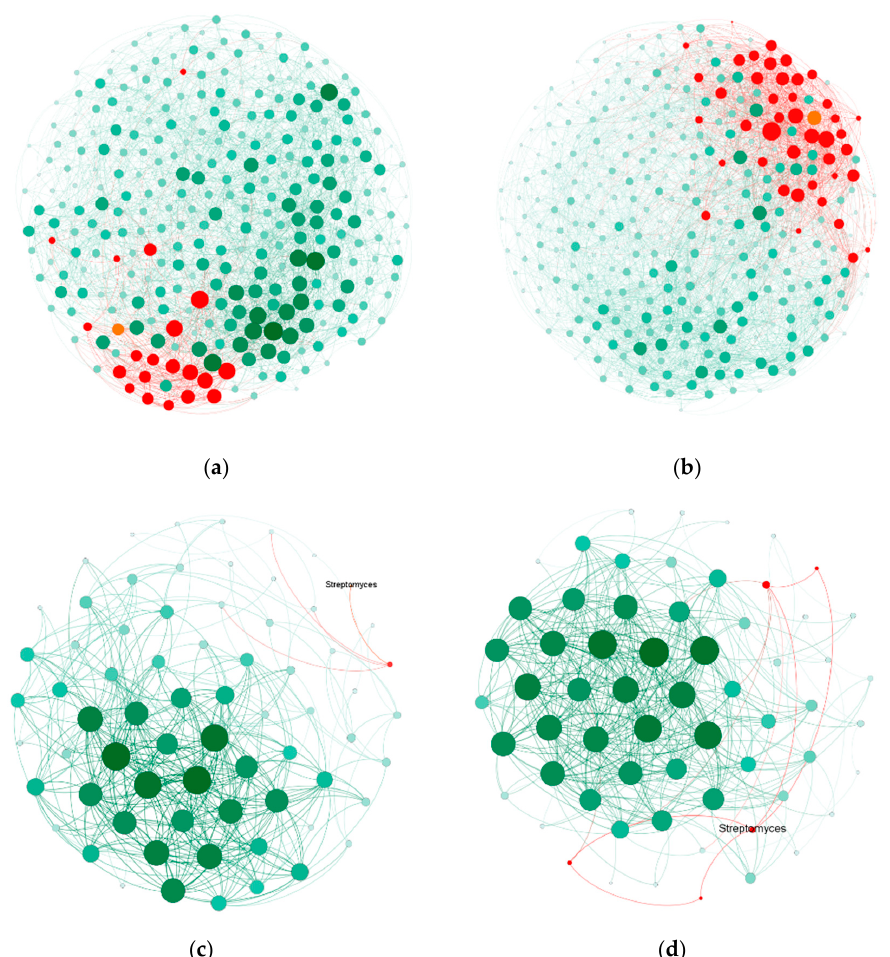
Figure 5. Co-occurrence networks of microbial genera in the rhizosphere soil of cucumber. ( a ) Bacterial network of the control soil; ( b ) bacterial network of Streptomyces- treated soil; ( c ) fungal network of the control soil; ( d ) fungal network of Streptomyces -treated soil. Orange spots refer to the genera of Streptomyces , red spots refer to the genera significantly correlated with Streptomyces , and green spots refer to other genera. Spot size indicates the strength of the connection to the genera.